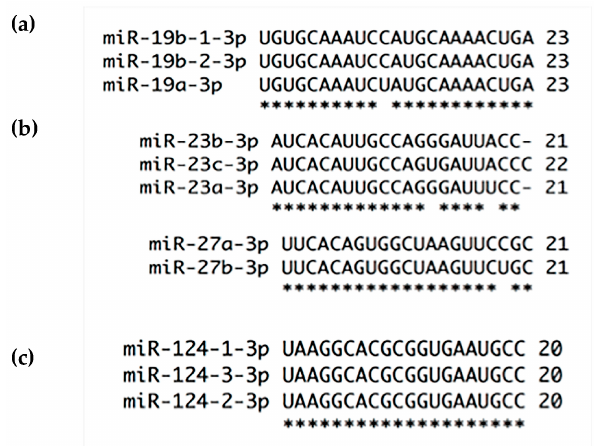
Figure 4. Alignments of miRNAs families by 3p strand used and nt chain sizes: ( a ) miR-19 family has 23 nt of length and share 100% of strand conservation; ( b ) miR-23 and miR-27 families are in general 21 nt in length except for miR-23c (22 nt). The former has 86.36% while miR-27 has 95.23% strand conservation; ( c ) miR-124 family shares 100% strand conservation and its members are 20 nt in size. * at the bottom of the alignment indicates nt homology between family members.